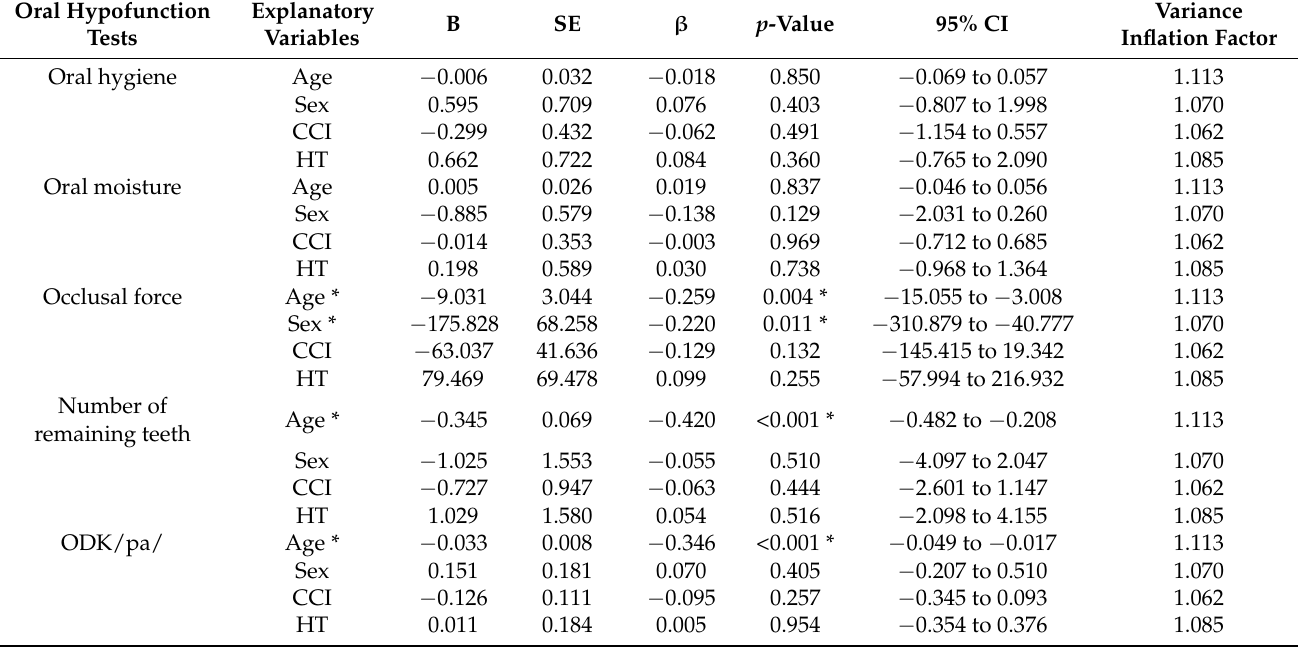
Table 4. Multiple regression analysis with oral hypofunction tests as the objective